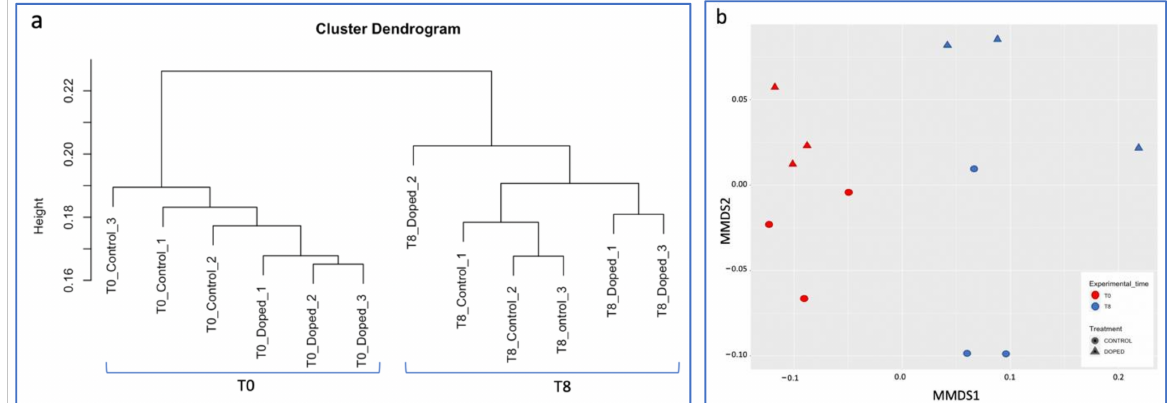
Figure 9. ( a ) Cluster dendrogram analysis of Hellinger transformation using the Bray–Curtis dissimilarity matrix and ( b ) NMDS analysis of data transformed by “phyloseq” function and based on the Bray–Curtis dissimilarity matrix to ordinate microbial community composition of the different CWs systems, irrigated for eight weeks with Ribeira de Joane water not doped (control) or doped with PCP. Samples collected at the beginning (T0) and at the end of the experiment (T8) ( n = 3). The Kruskal–Wallis test was conducted to examine the difference between microbial communities of each sample.